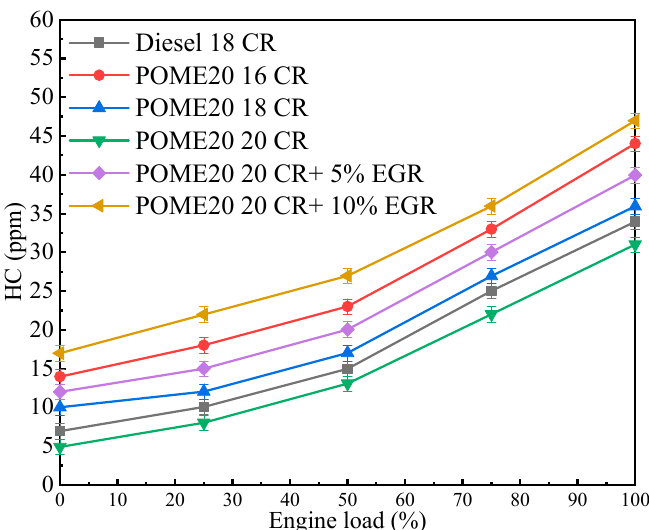
Figure 31. HC emission comparison of POME biodiesel and diesel under different loads [241]. Moreover, Baweja et al. [203] used biodiesel produced from mustard oil methyl esters and also observed higher HC emissions than diesel. They indicated that more fuel injected into the cylinder leads to a poor fuel mixture, thus increasing HC emissions. Ramesh et al. [251] used biodiesel produced from Karanja and observed higher HC emissions with bio ‐ diesel blends than with diesel. They explained that poor atomization and vaporization of Karanja biodiesel led to incomplete combustion and incomplete oxidation; thus, HC emis ‐ sions increased. Wei et al. [252] used n ‐ pentanol addition on biodiesel and observed higher HC emissions compared to diesel. They explained that the smaller CN of n ‐ penta ‐ nol results in a longer ignition delay; thus, more time for vaporization leads to a broader lean outer flame zone, which results in higher HC emissions with the addition of n ‐ pen ‐ tanol. In a summary of HC emissions fueled with different biodiesel and diesel blends, most researchers have observed an average of 33.89% HC reduction with different types of bi ‐ odiesels. This reduction can be explained due to 11–13% average oxygen content and higher CN of biodiesel, which leads to shorter ignition delay and higher combustion tem ‐ perature. The oxygen content of biodiesel leads to more HC oxidization, thus reducing HC emissions. On the other hand, in some literature, biodiesel has poor atomization and evaporation due to its higher density, viscosity, and lower calorific value, and these fac ‐ tors increased the HC emissions of biodiesel. 5.5. Effect on Smoke Emissions Smoke is an incomplete product of fuel during combustion. Many previous studies have shown that smoke may form due to fuel ‐ rich areas and oxygen levels in the fuel and intake air [253,254]. In this section, the smoke emissions from the use of diesel engine al ‐ ternative fuel biodiesel are summarized. Hazar et al. [255] observed fewer smoke emissions in diesel engines for biodiesel pro ‐ duced from safflower methyl esters. They explained that the oxygen content in biodiesel increased the end of combustion temperature, resulting in better combustion and de ‐ creased smoke formation under all load conditions. Similar trends were also observed by Uyumaz [256] using mustard methyl esters. According to their research, at full load, the smoke emissions of diesel, B10, B20, and B30 were determined to be 3.99 m − 1 , 2.67 m − 1 , 1.95 m − 1 , and 1.57 m − 1 , respectively. The main reason is that the oxidation is more complete due